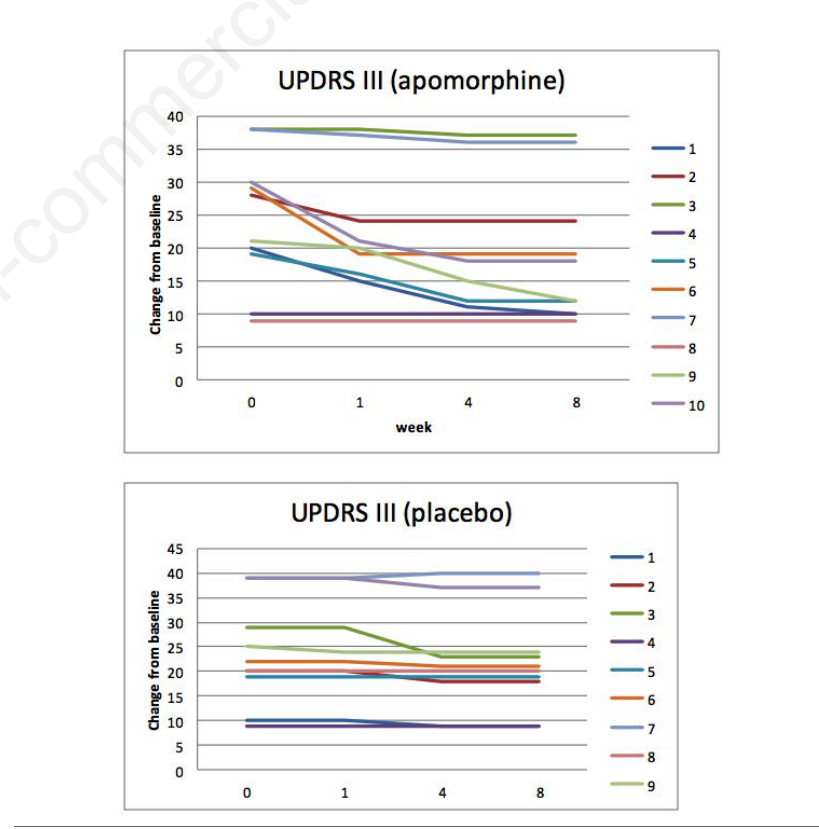
Figure 3. Total scores change from baseline over time (weeks) in UPDRS part III. Apomorphine and placebo